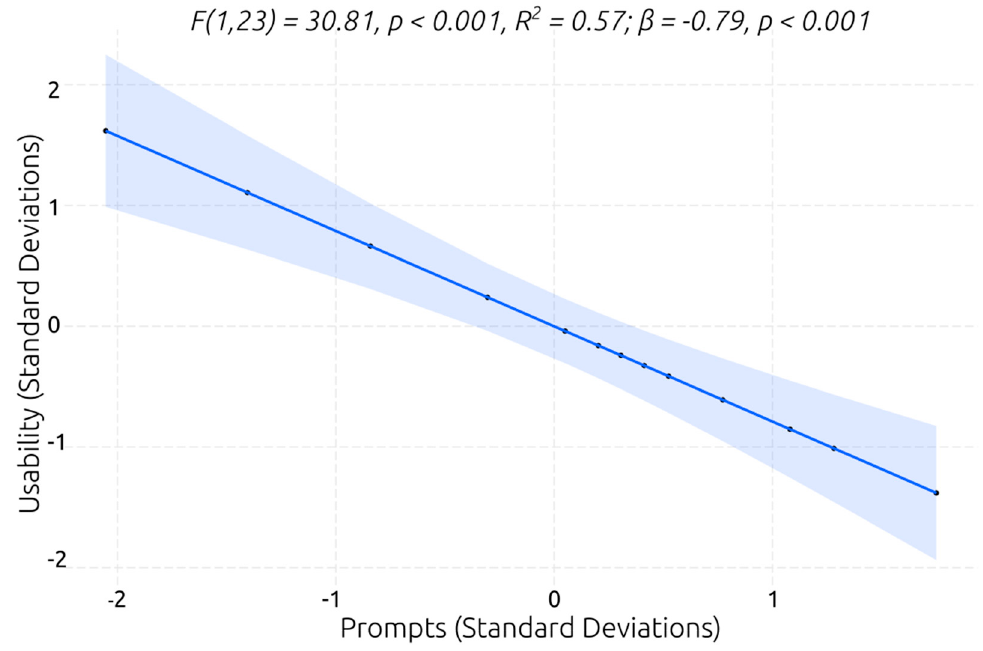
Figure 14. Best linear regression model for predicting system’s perceived usability.